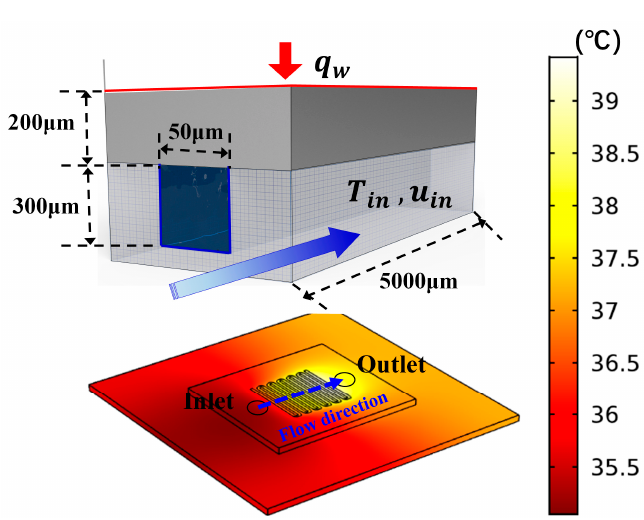
Figure 5. The simulation model of studying the temperature fluctuation in the MCHS.